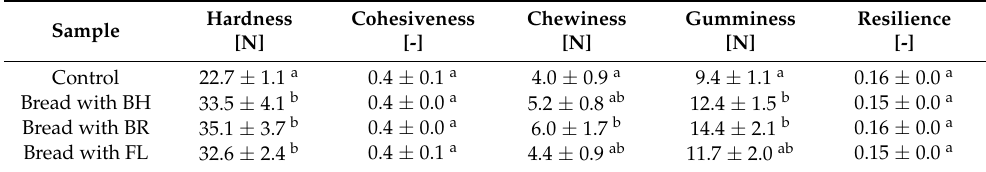
Table 8. Texture parameters of bread